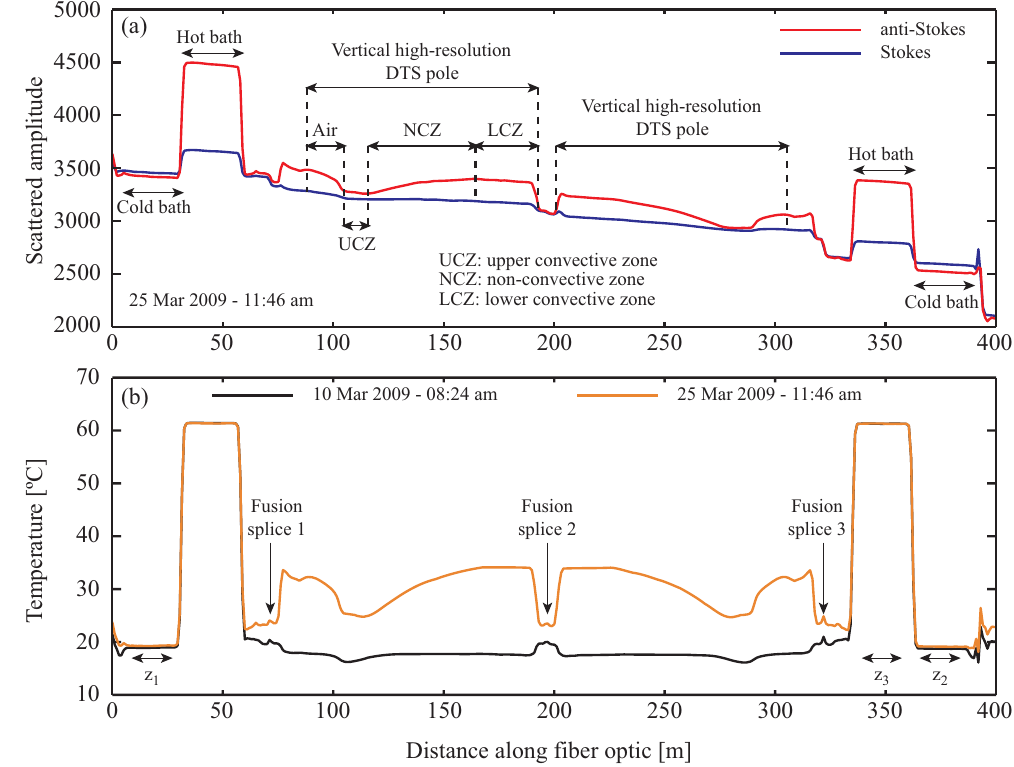
Fig. 2. (a) Typical Raman-scattering traces obtained during the experiment show the impact of temperature on the anti-Stokes and Stokes signals. Locations of the system components (cold and hot baths, vertical high-resolution DTS pole) are also shown. (b) Typical temperature traces measured during the experiment (obtained using the manufacturer-internal calibration method). The black line was obtained at the beginning of the experiment and the orange line was obtained after 15